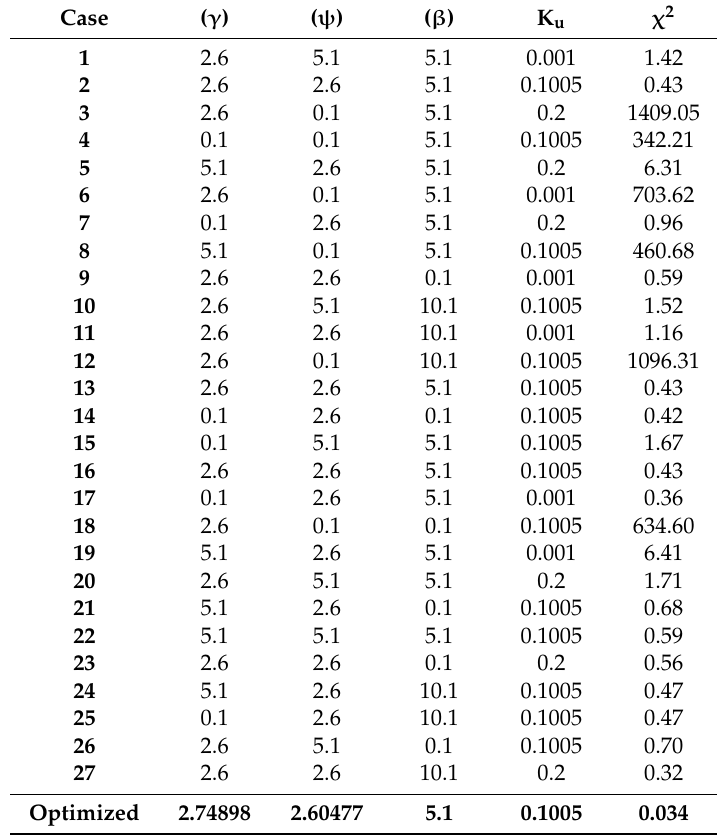
Table 4. Obtained χ 2 for 27 different set of pitting parameters obtained from the RSM technique. The optimized pitting parameters are provided based on the lowest value observed for χ 2 . Case ( γ